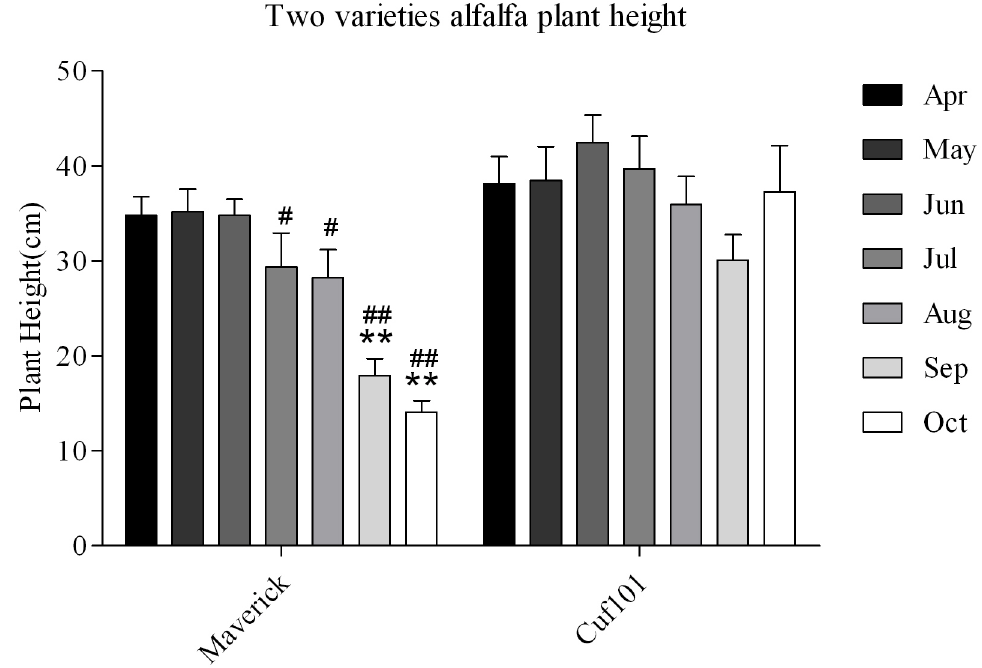
Fig 3. Plant height of Maverickand CUF101varieties from April to October. The difference in plant heightin Maverick is marked with * . The difference in plant heightbetweenMaverick and CUF101is marked with #. ( * , #, p < 0.05; ** , ## p <